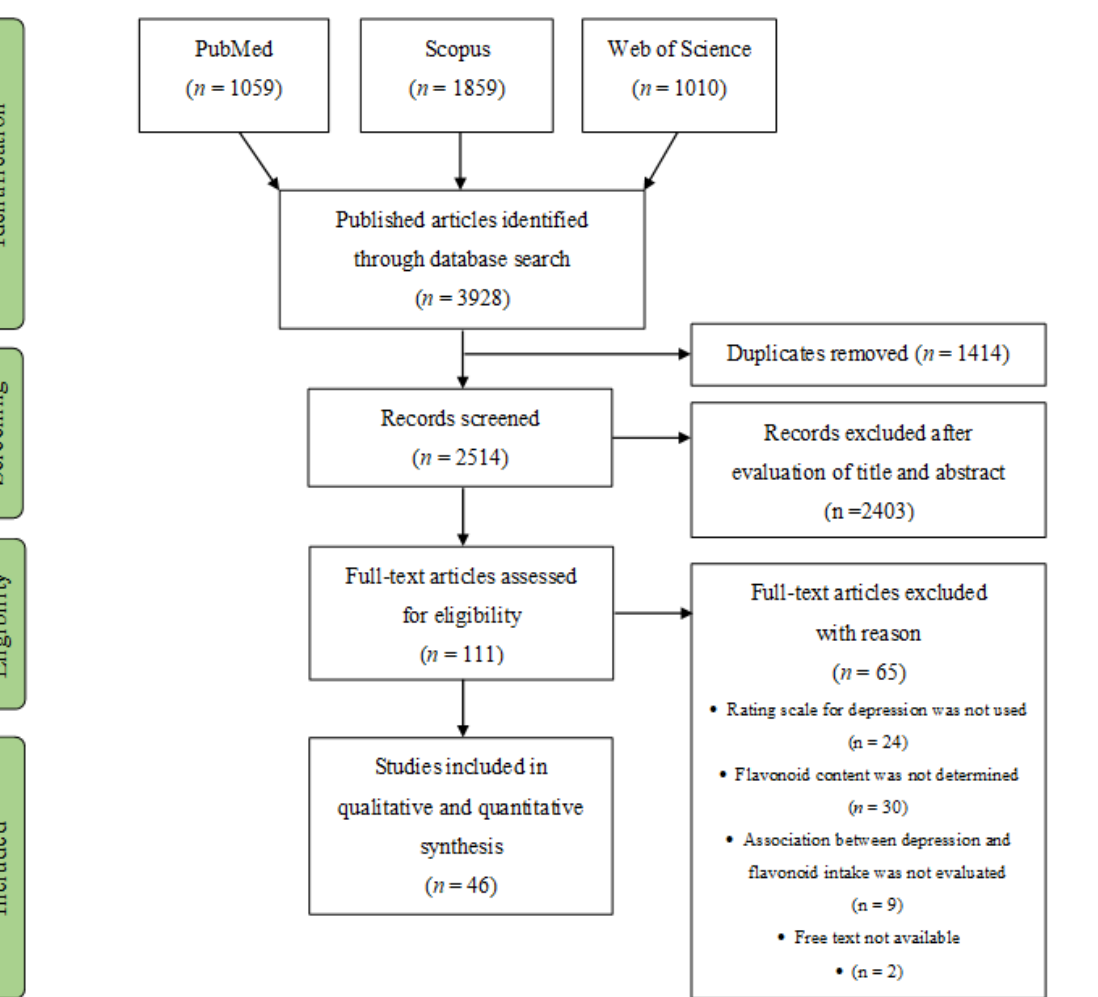
Figure 1. PRISMA flow diagram for systematic review and meta-analysis.